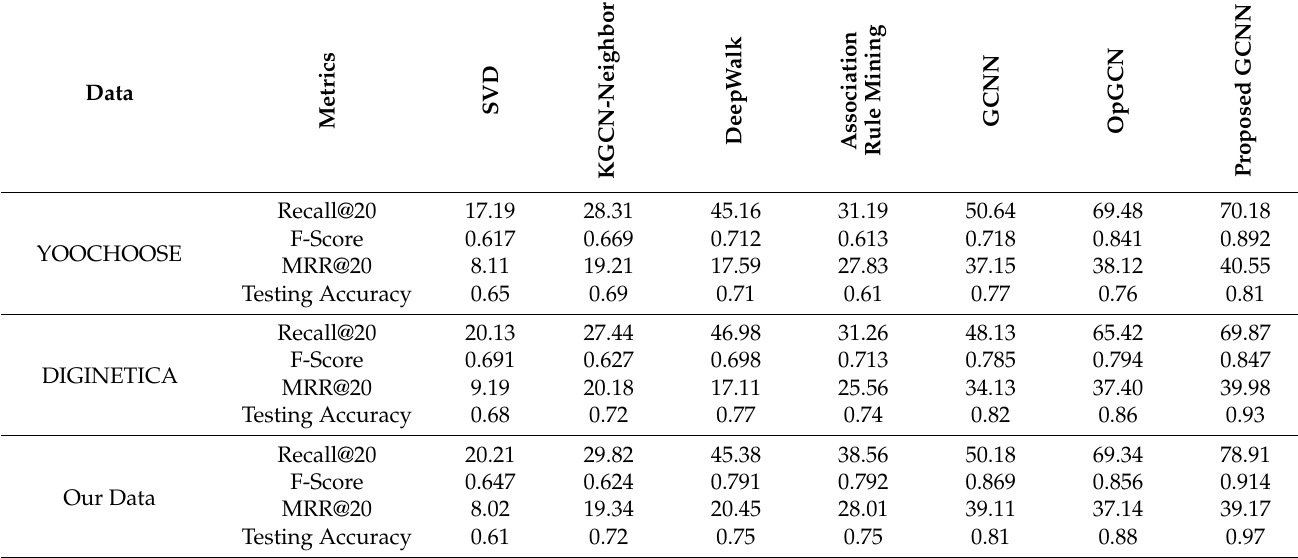
Table 5. Performance comparisons for different datasets with different